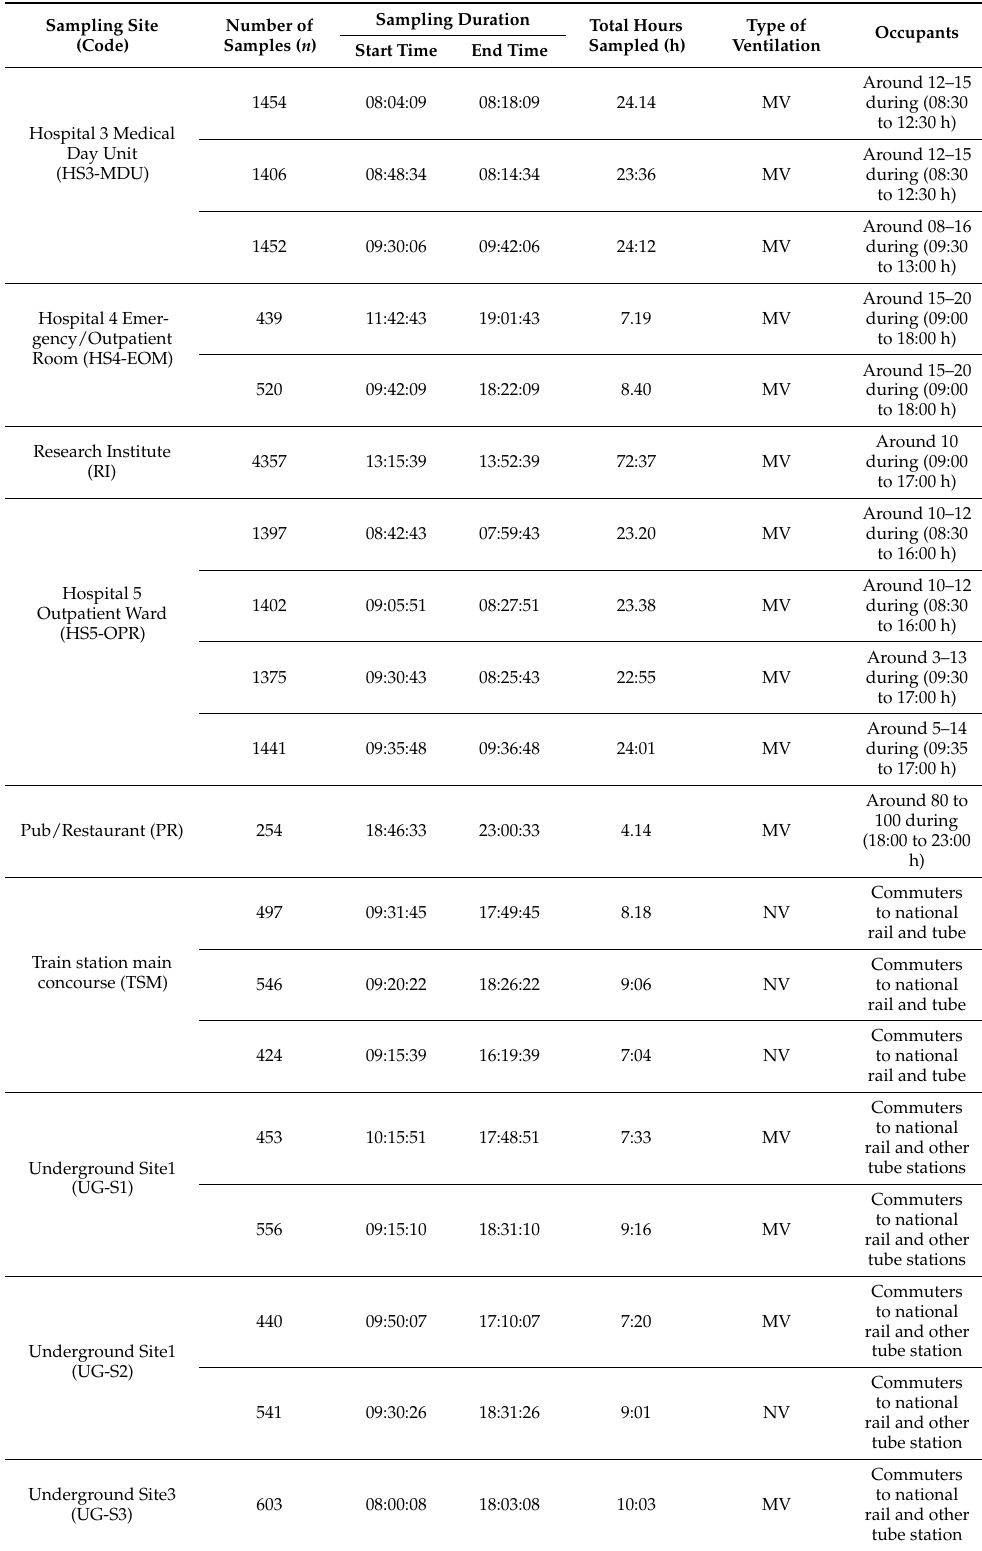
Table 2. Cont. Sampling Site (Code)